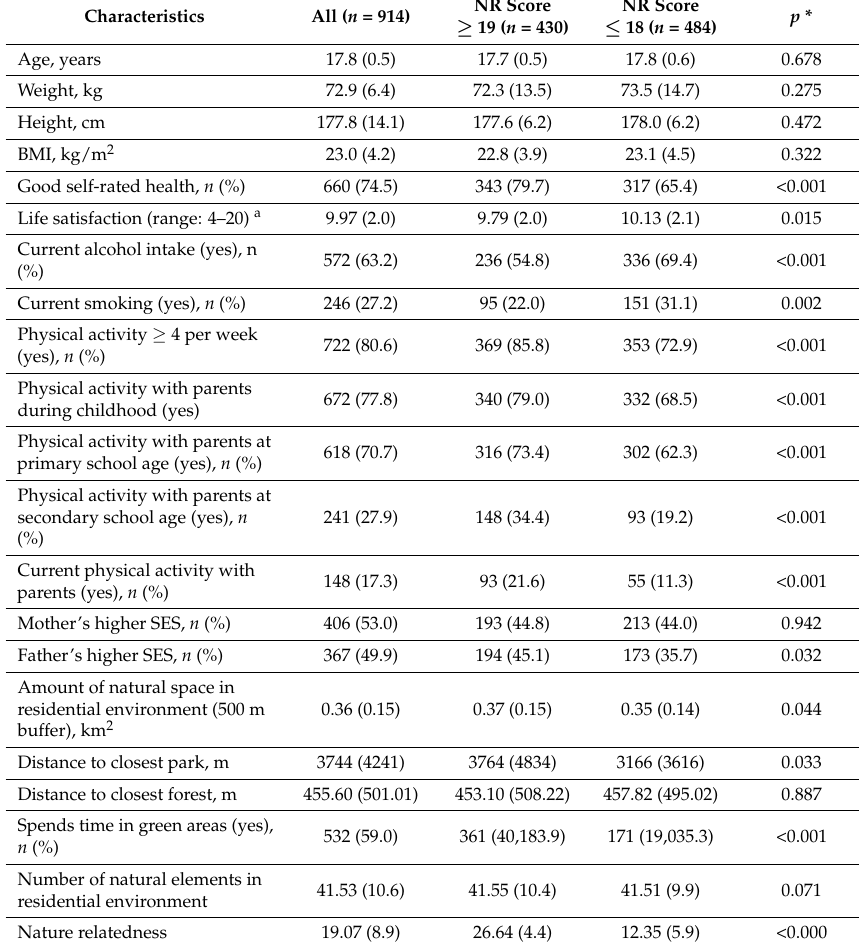
Table 1. Characteristics of the study population ( n = 914) by nature relatedness (NR) *. Values are means (SD) if not otherwise